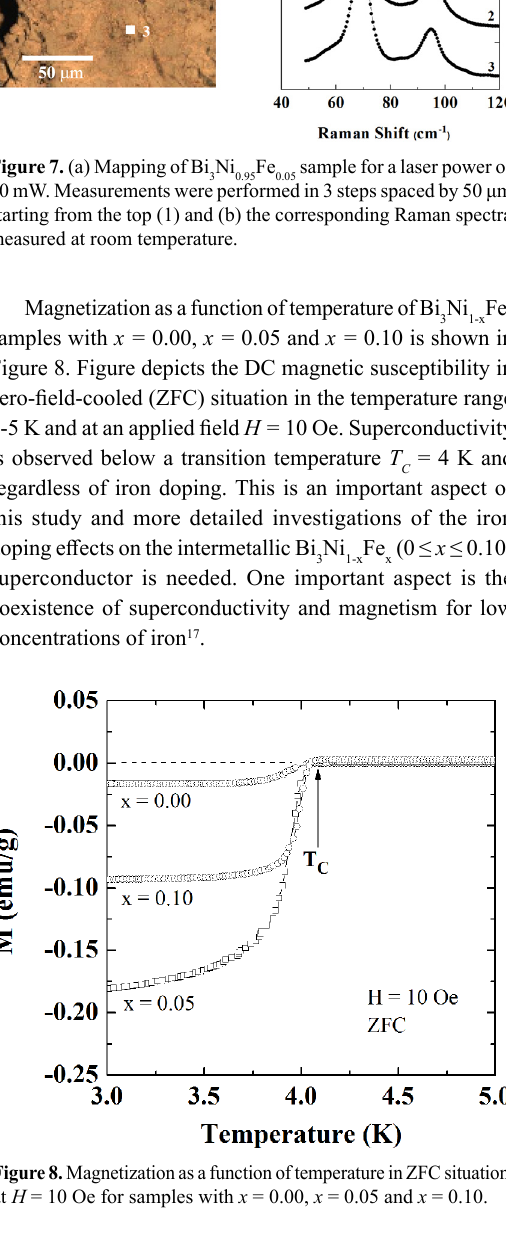
Ni Fe sample for a laser power of 3 0.95 0.05